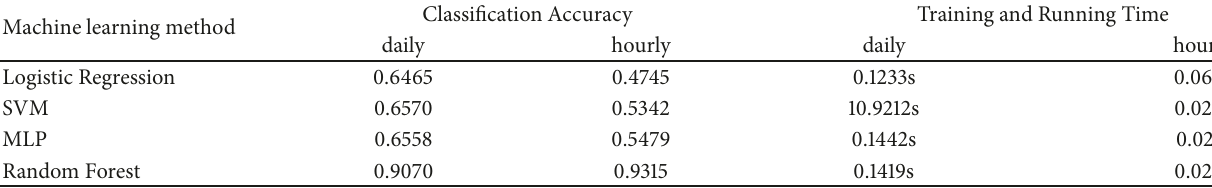
Table 5: Classifier accuracy, training, and testing